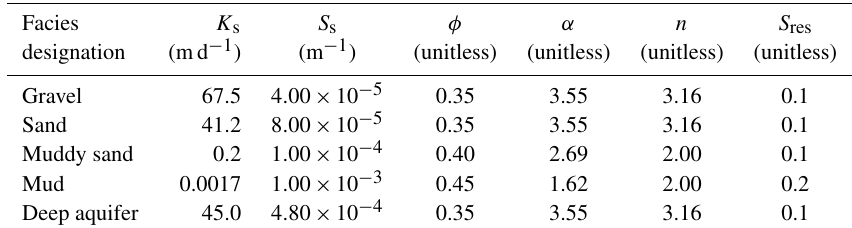
Table 2. Calibrated hydrofacies hydraulic properties (Liu, 2014).